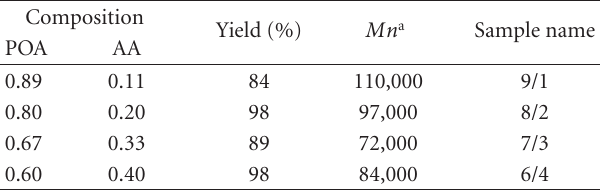
a Estimated by GPC based on poly(methyl methacrylate) standard.